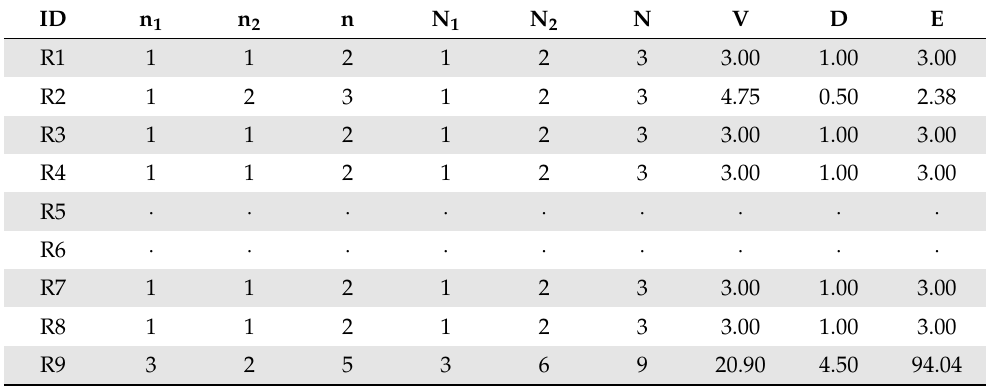
Table A6. Metrics calculations for